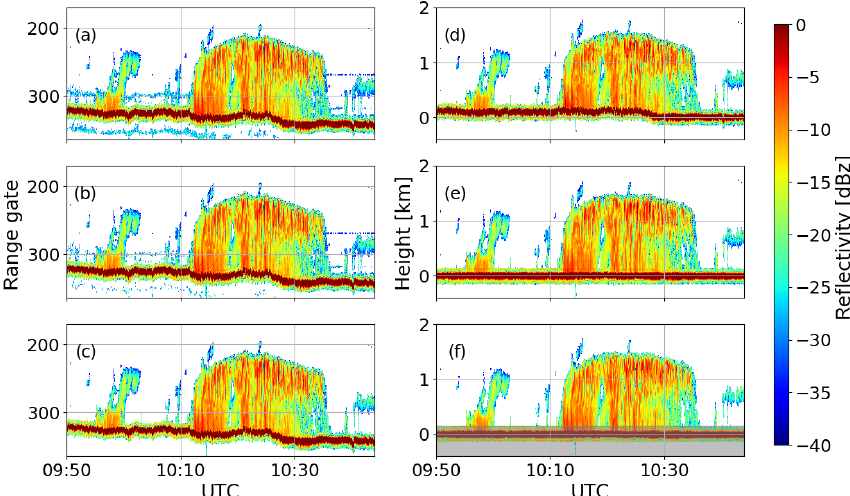
Figure 5. Time series of Z e profiles measured during RF06 on 27 May 2017 for different processing steps (see Table 3): (a) raw data; (b) after subtraction of mirror signal; (c) after speckle filter; (d) filtered data on a time–height grid; (e) corrected for sensor altitude, mounting position, pitch, and roll angle; and (f) remapped onto a constant vertical grid. The grey shading indicates the range of surface contamination ( ≤ 150m).